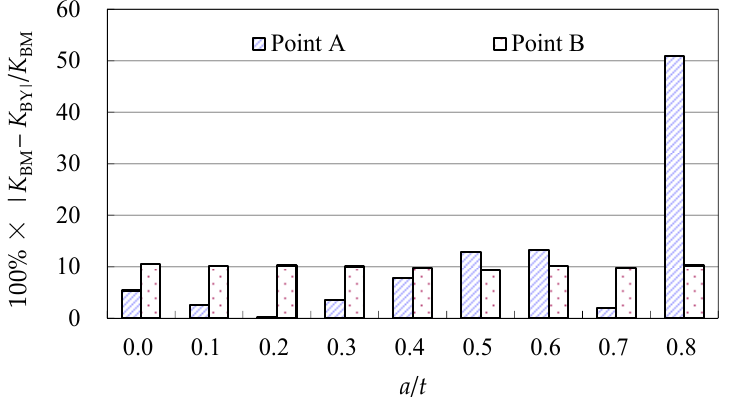
Figure 2. The Baik-Yamada formula vs. the benchmark results ( a / c = 0.5).